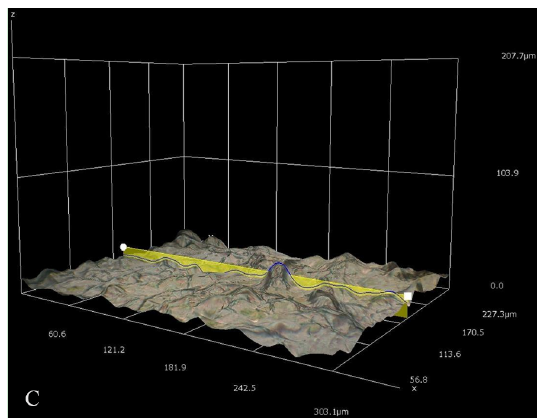
Figure 6. Different three ‐ dimensional representations using 3D Hirox digital microscopy. ( A ) Profiling of pristine mPE ‐ nHA at 1000×; ( B ) Profiling of 12 h Aloe vera dip ‐ coated mPE ‐ nHA at 1000×; ( C ) Profiling of 24 h Aloe vera dip ‐ coated mPE ‐ nHA at 1000×.